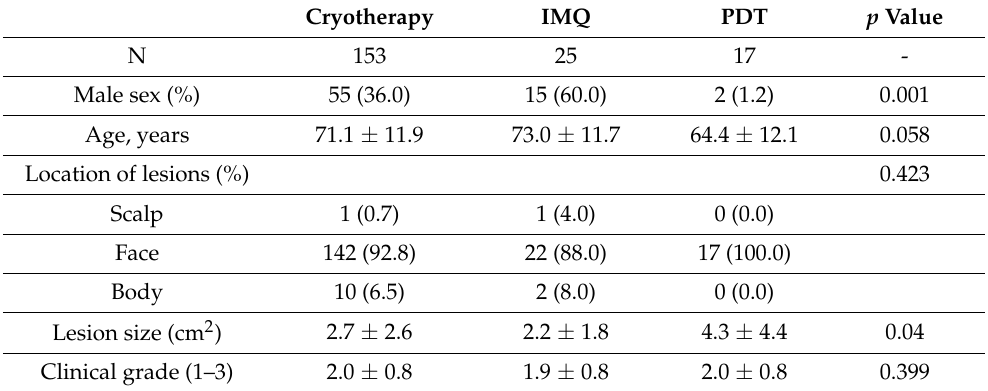
Table 1. General characteristics of the study population.